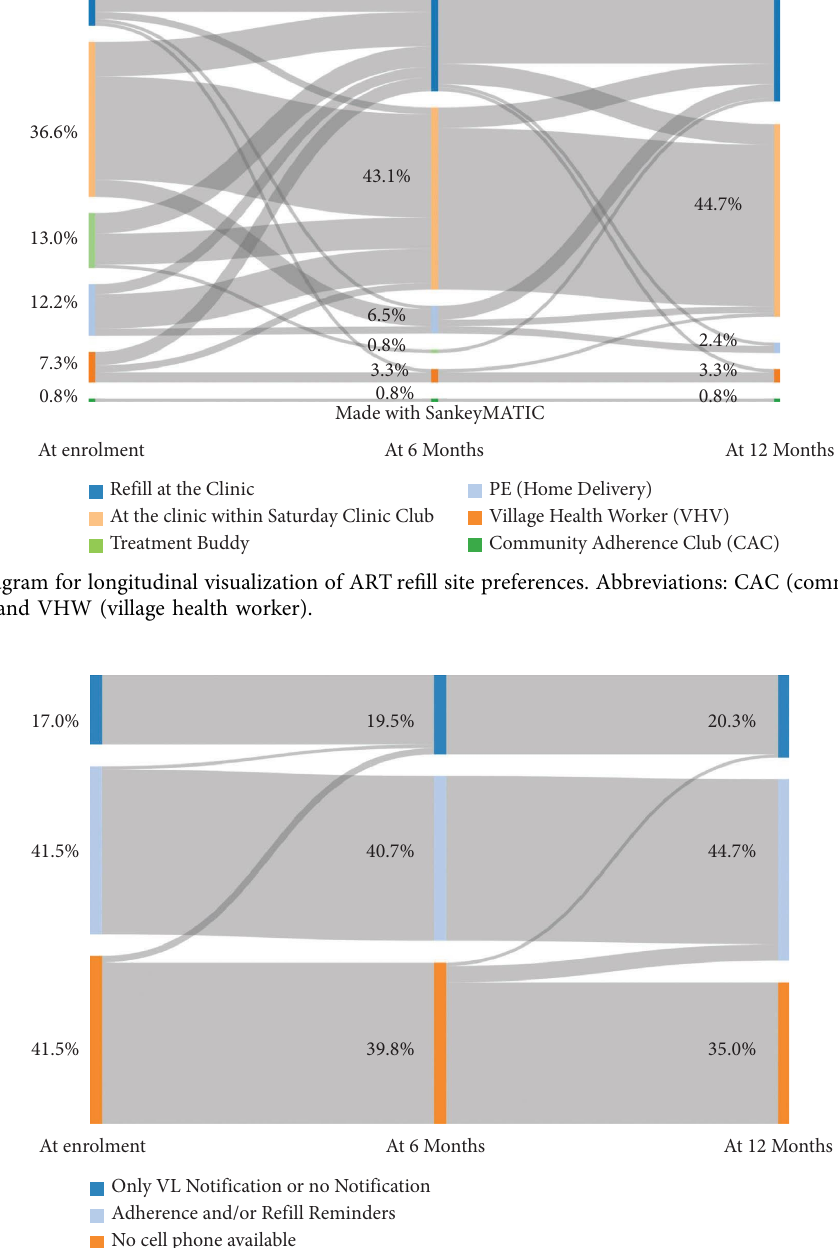
Figure 2: Sankey diagram for longitudinal visualization of SMS notifcation preferences. Abbreviations: VL (viral